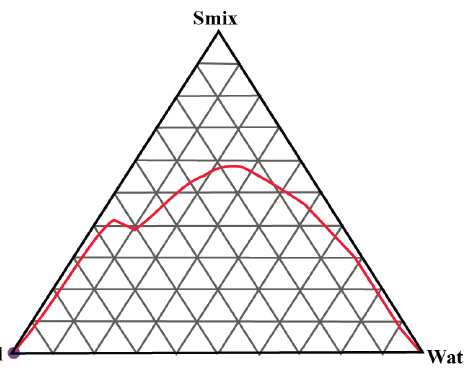
Figure 2. Pseudoternary phase diagram between IPP, water and S mix (2:1). The red line shows the boundary between the monophasic and biphasic region. The area above redline represents the monophasic region.